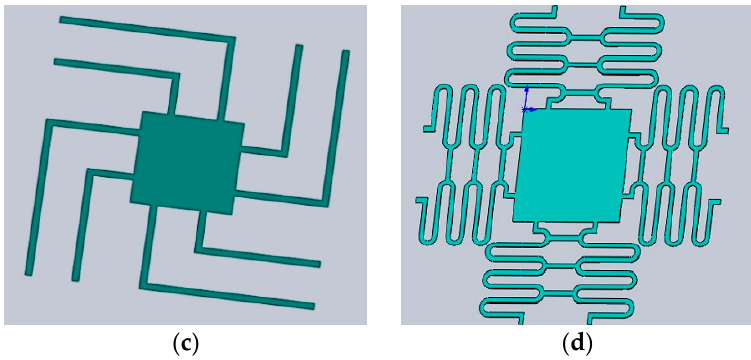
Figure 3. Four kinds of cantilever beam structure. ( a ) U-type; ( b ) N-type; ( c ) L-type; ( d ) W-type.